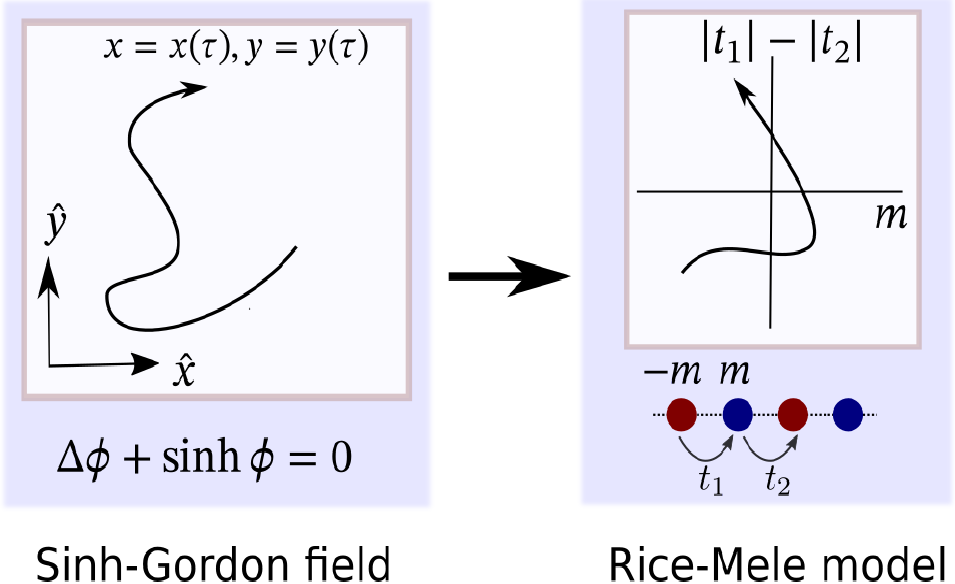
Figure 3: The mapping of the zero-curvature representation on Rice-Mele model. We specify the time-dependent parameters t , m , by choosing specific solution φ , a path i in x,y plane and using the relations (22) and